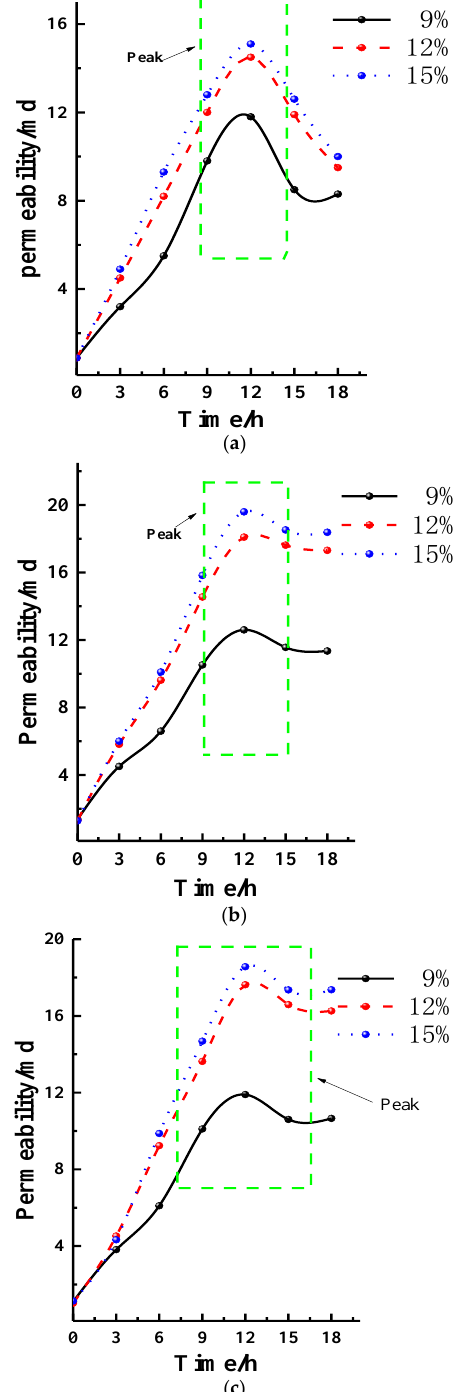
Figure 12. Change rule of coal specimen’s permeability. ( a ) Qian Jiaying; ( b ) Xiao nan; ( c ) Liu jia.